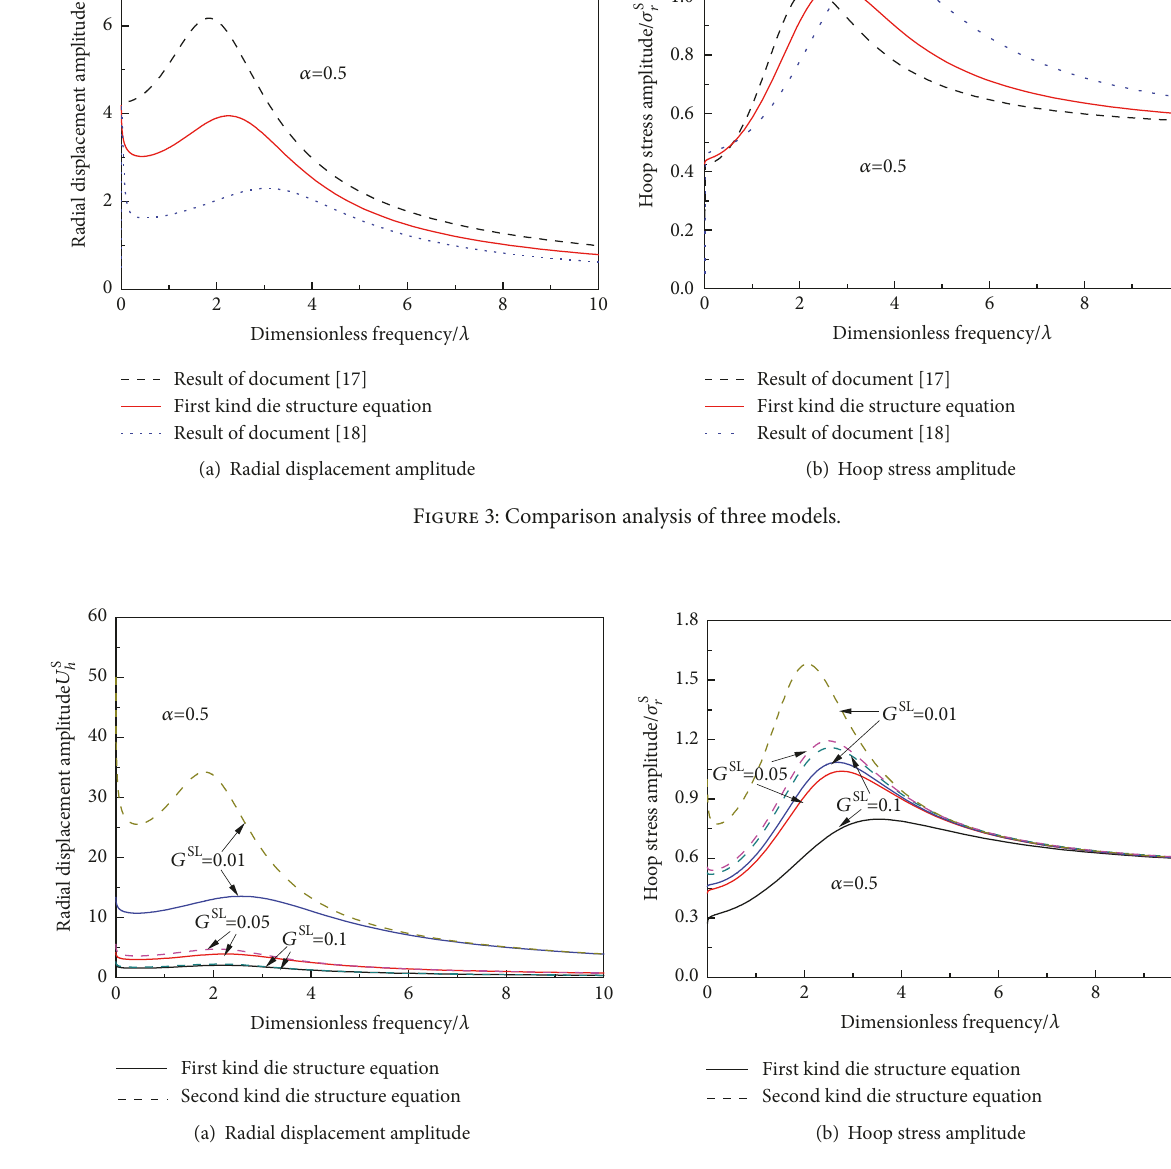
Figure 4: Influence of modulus ratio on radial displacement and hoop stress